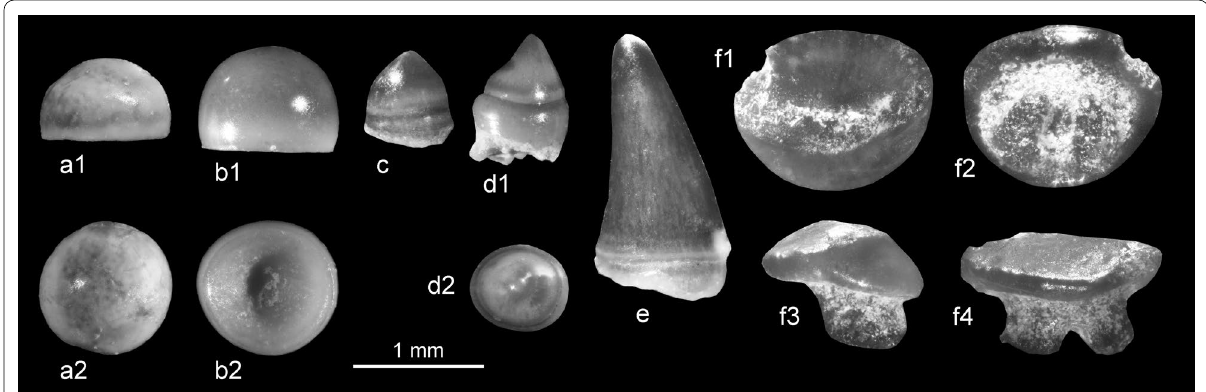
Fig. 10 Fish teeth from the studied localities: a – e Pshekharus yesinorum Bannikov & Kotlyar, 2015, isolated jaw teeth in lateral (a1, b1, c, d1, e) and dorsal view (a2, b2, d2), arranged in a sequence from distal to proximal positions. f Dasyatis sp., anterior tooth in dorsal (f1), occlusal view (f2), profile (f3) and labial view